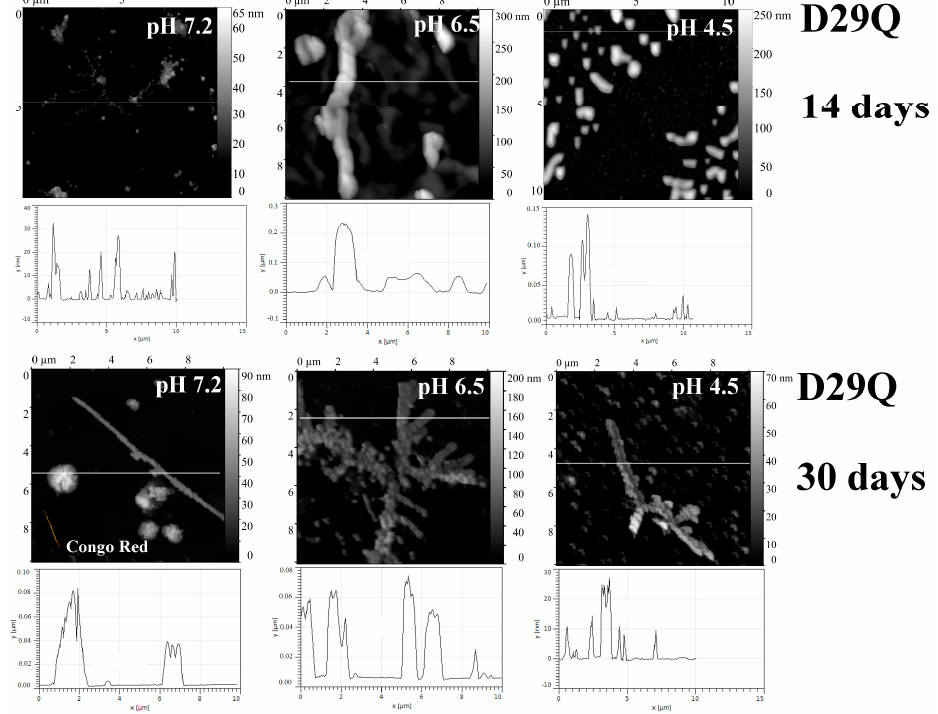
Figure 9. The morphology of D29Q aggregates at pH 7.2, 6.5 and 4.5 after 14 days and 30 days of incubation at 37 °C (AFM images obtained in tapping mode). Congo Red birefringence is shown.